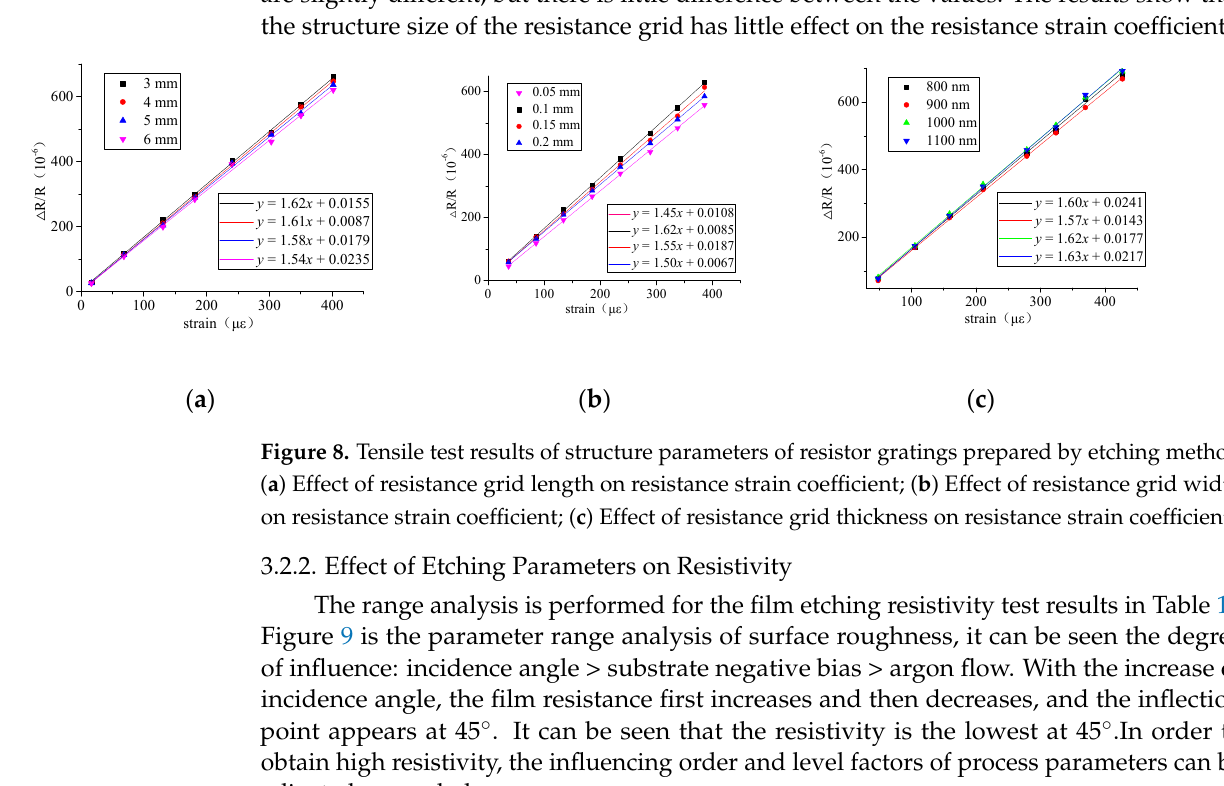
Figure 9. Parameter range analysis of film resistivity. 4. Calibration of Sensor Strain Coefficient In the experiment of calibrating, unidirectional force is applied to the thin-film strain sensor by tensile tester. There is experiment device in Figure 10a, using a DH5929 dynamic signal test and analysis system to collect strain values of 16 thin film resistor grids that form four groups of Wheatstone bridges, as shown in Figure 10b. The